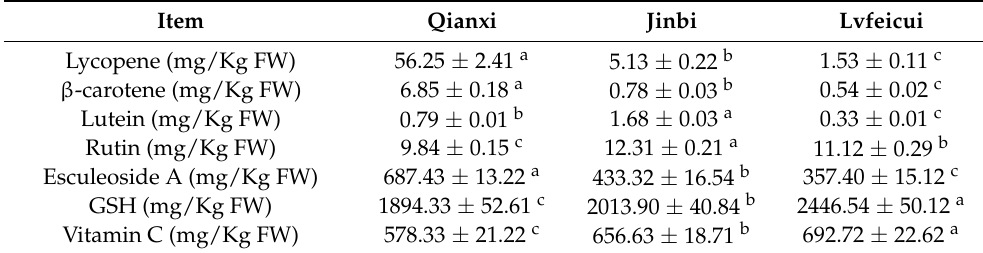
Table 3. Bioactive components of three different kinds of cherry